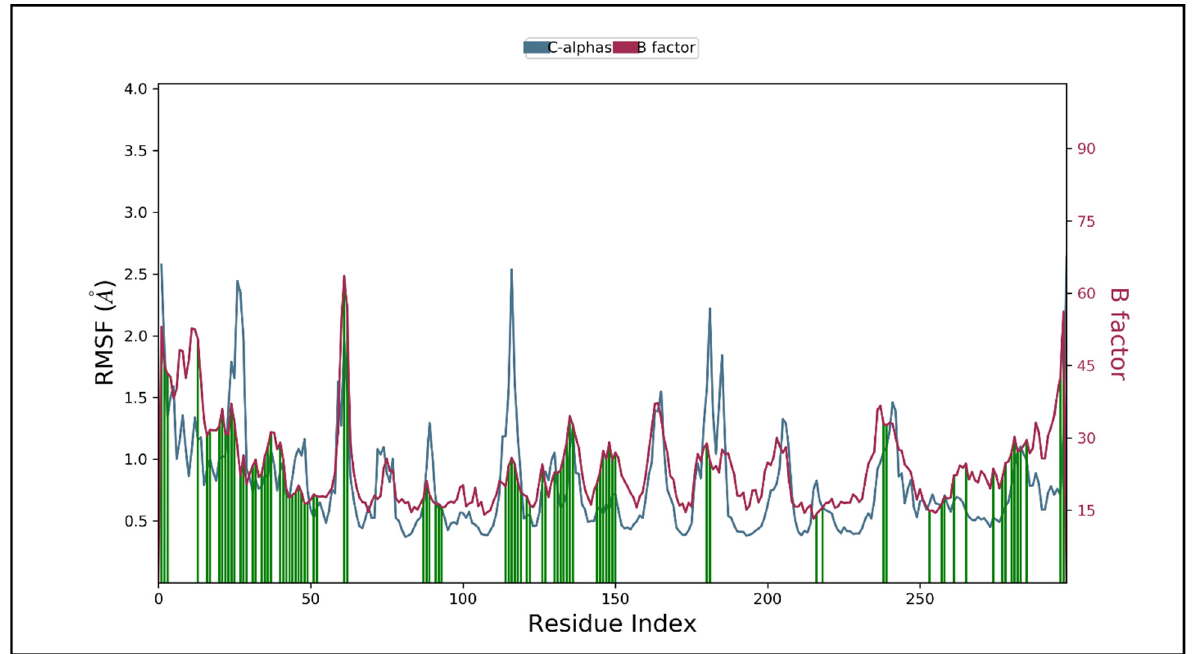
Figure 10. The RMSF protein backbone and ligand complex, the red color shows the B factor, which means the PDB and green shows the interaction of the ligand to the protein.